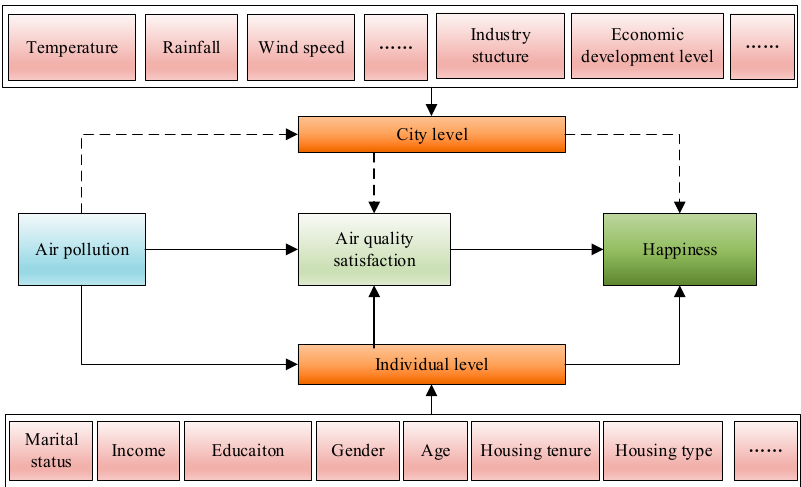
Figure 1. The conceptual framework of this study.